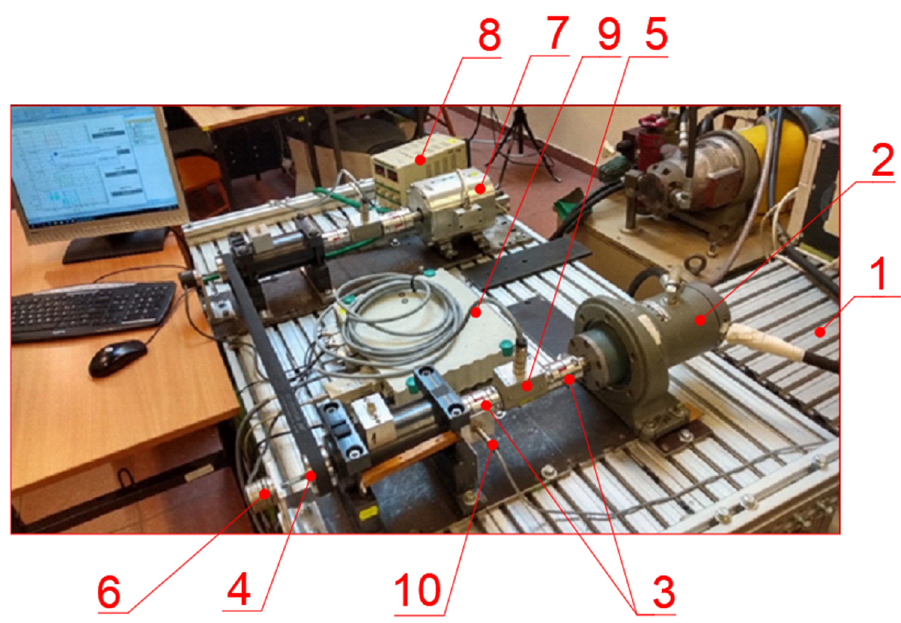
Energies 2022 , 15 , x FOR PEER REVIEW 5 of 12 Figure 4. CFG flat lane ( a ) photography, ( b ) belt cross section, ( c ) optical light microscopy images of the internal structure. 2.2. Test Stand The aims of the work were realized by utilizing a test rig with two equal diameter wheels of 63 mm (ratio 1:1), with a belt width of 20 mm in each case and a shaft center distance of 660 mm (Figure 5). A hydraulic motor was mounted on the base of the stand. The transmission from the active shaft of the motor was transferred to the active shaft of the belt drive by utilizing flexible couplings. A torque meter was placed between the clutches. A rotary-code sensor was attached to the pulley face via a pin. Similarly, a torque